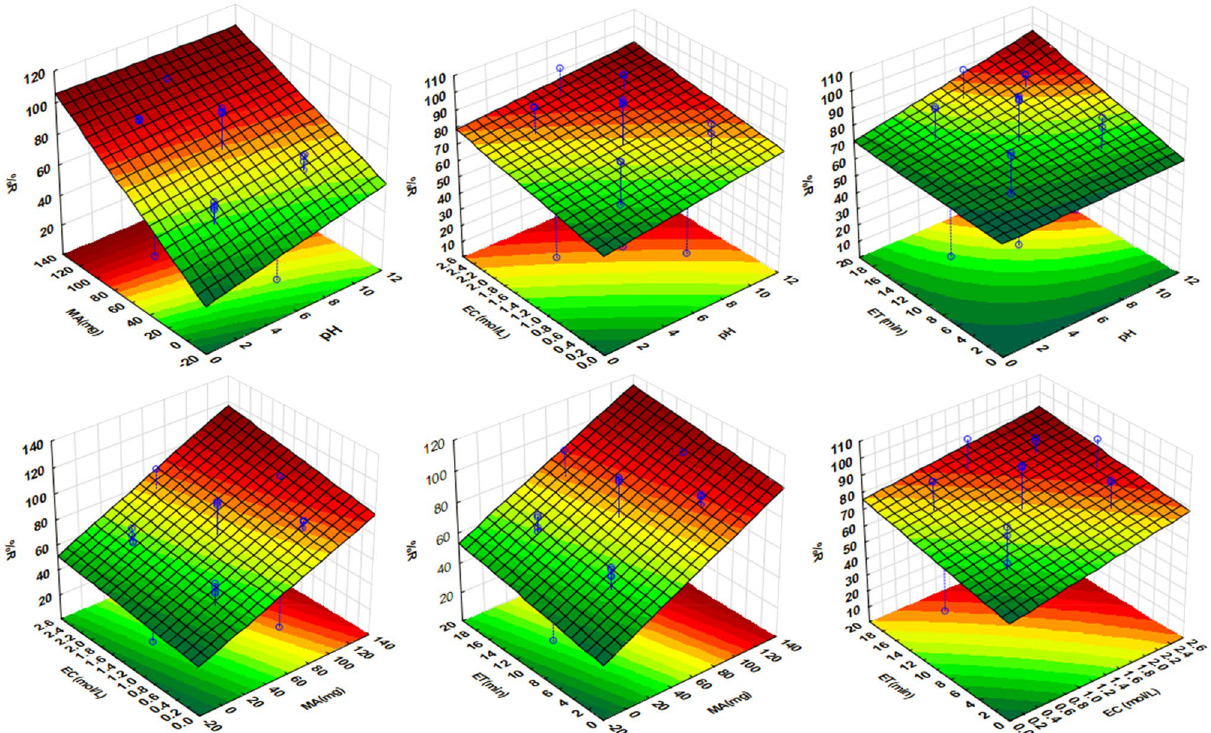
Figure 7. Three-dimension response surface plots for optimization of the independent variables.